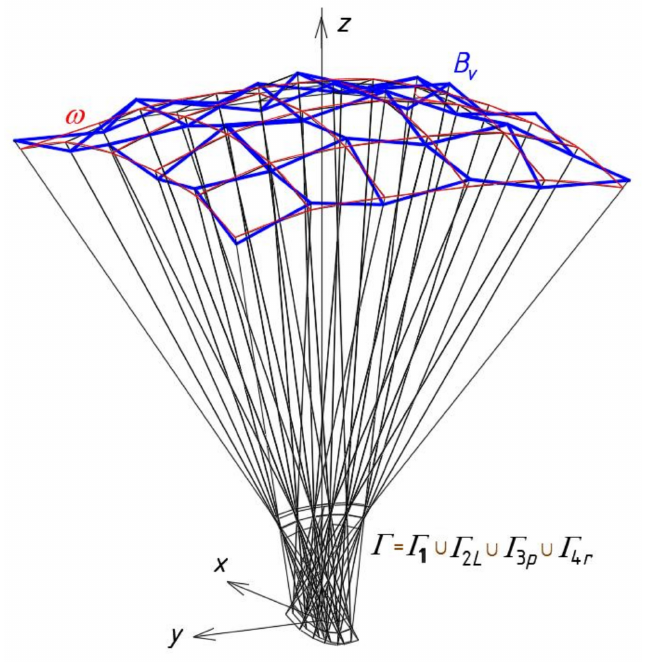
Figure 16. A multi-segment reference network Γ consisting of four symmetric subnets Γ 1 , Γ 2 L , Γ 3 p and Γ 4 r .